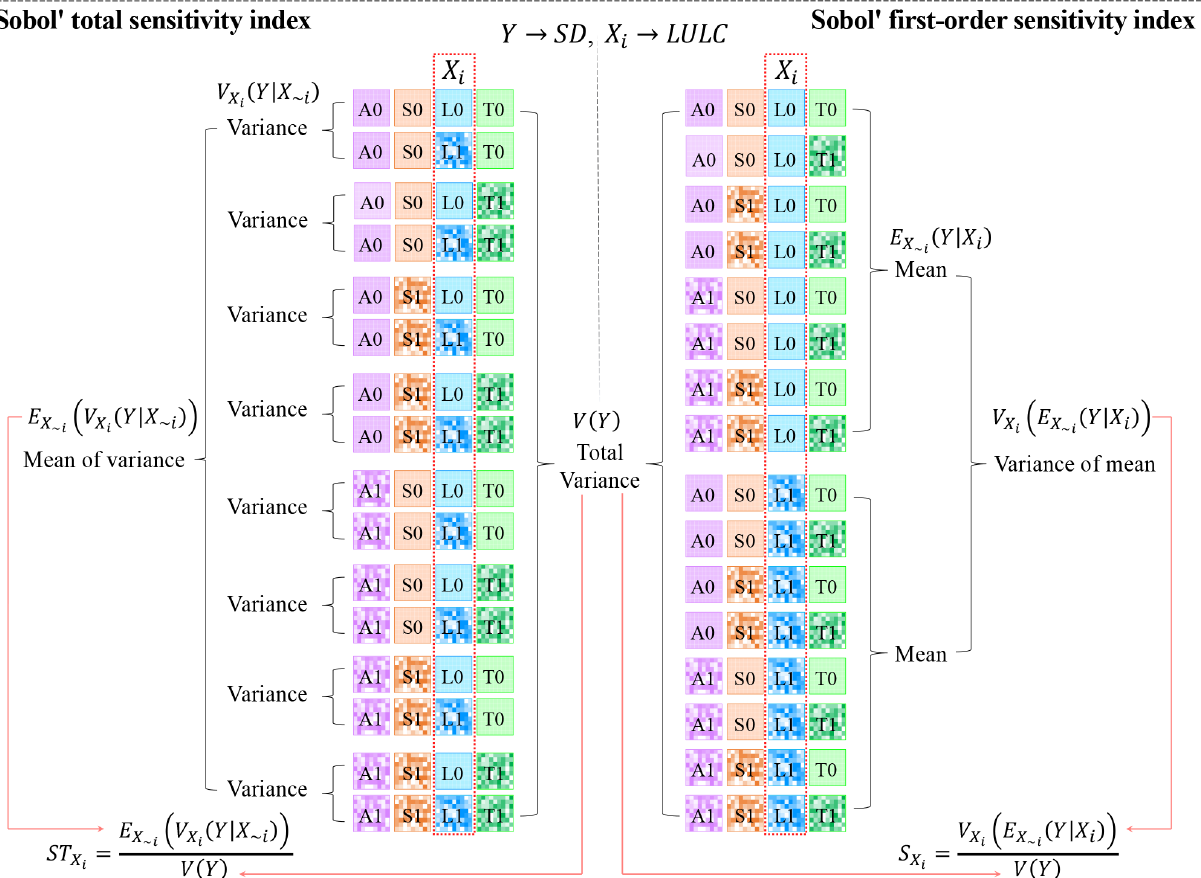
Figure 2. Schematic flowchart for the calculation of Sobol’ total and first-order indices for LULC (i.e., X i = LULC). The notation (e.g., A0, S0, L0, T0) in each box corresponds to the experiment abbreviation listed in Table 2. A box with (without) mosaic represents heterogeneous (homogeneous) input. The Sobol’ total sensitivity index is computed by dividing the 16 experiments into eight subgroups, such that in each subgroup, ATM, SOIL, and TOP are fixed, except for LULC. The Sobol’ first-order sensitivity index is computed by dividing the 16 experiments into two subgroups, such that in each subgroup, LULC is